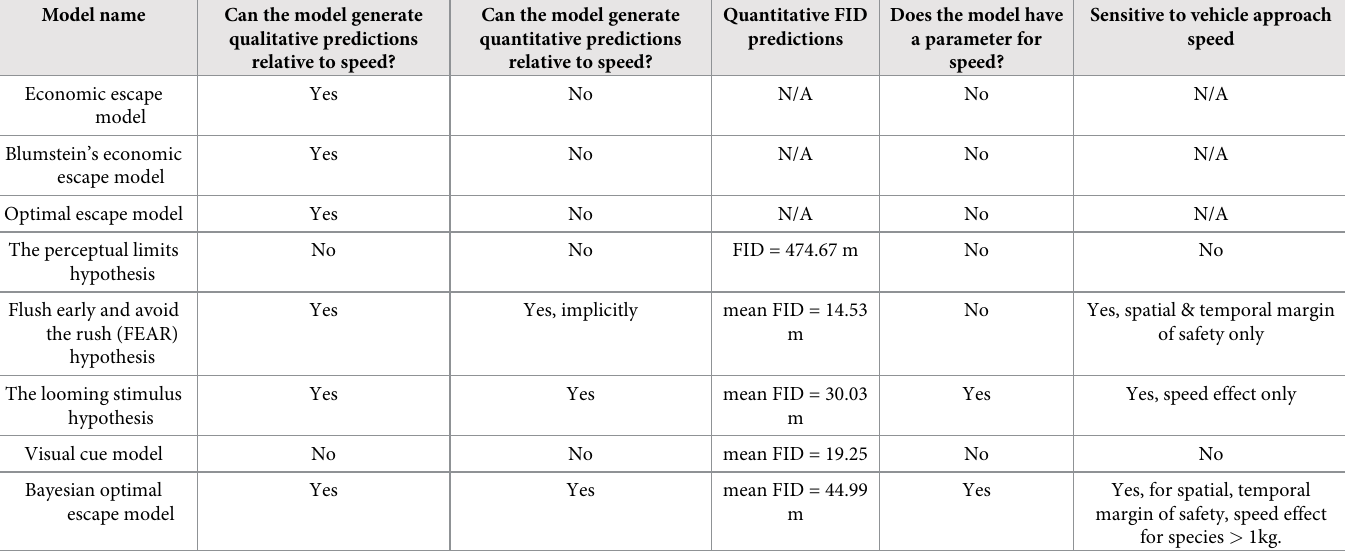
Table 1. Summary of each model